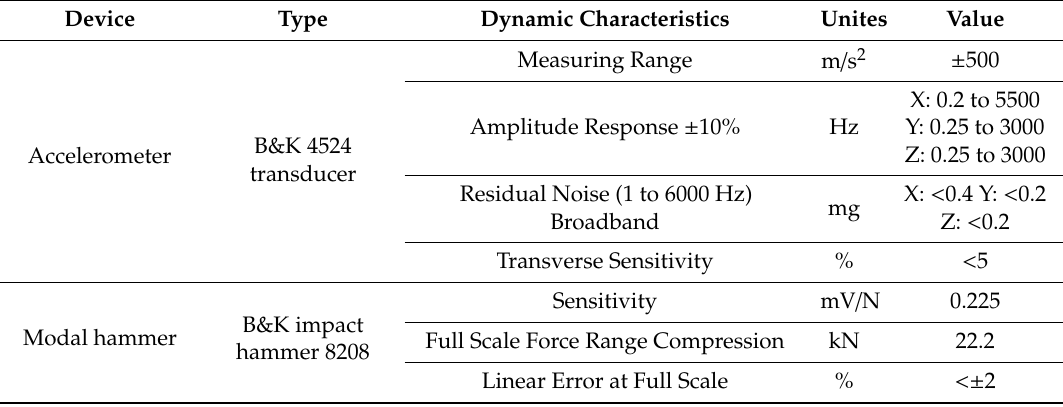
Table 2. Parameter settings in the PONTOS system.